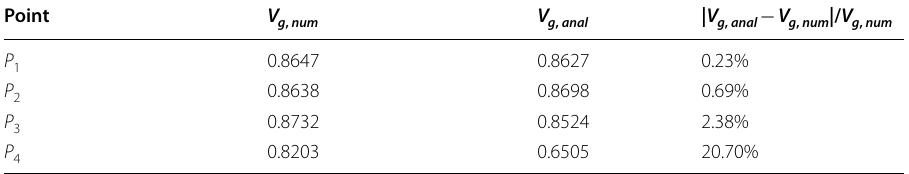
for WENO5-JS and RK i 4 V g , num |/ V g , num −